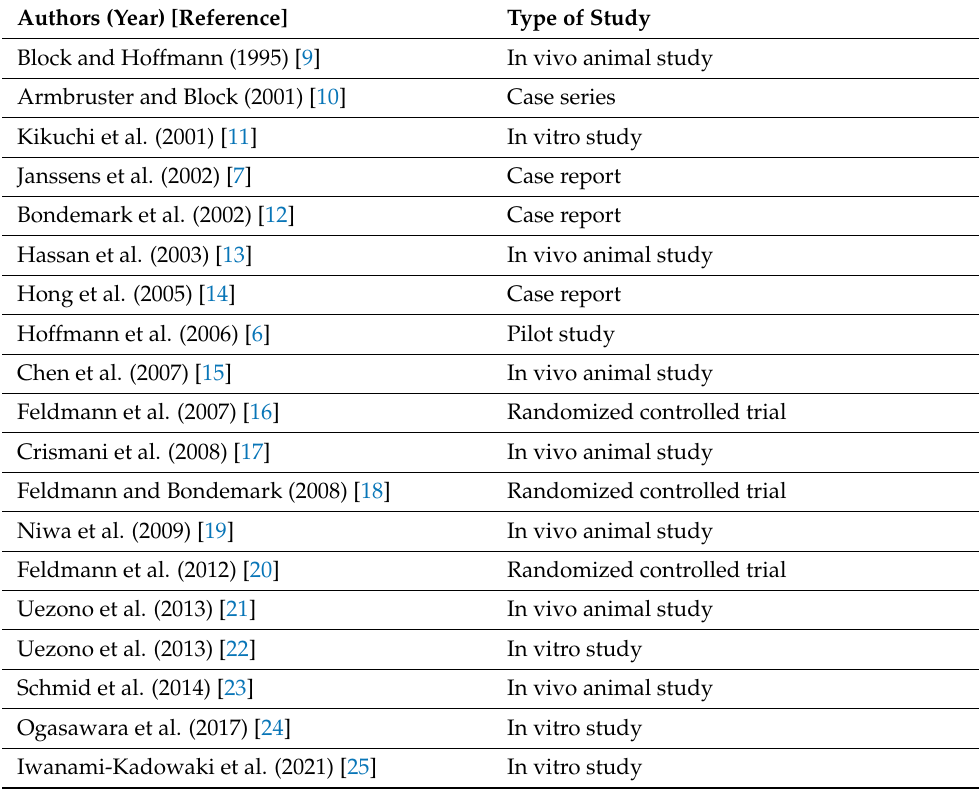
Table 1. Results of the database search based on the SPIDER